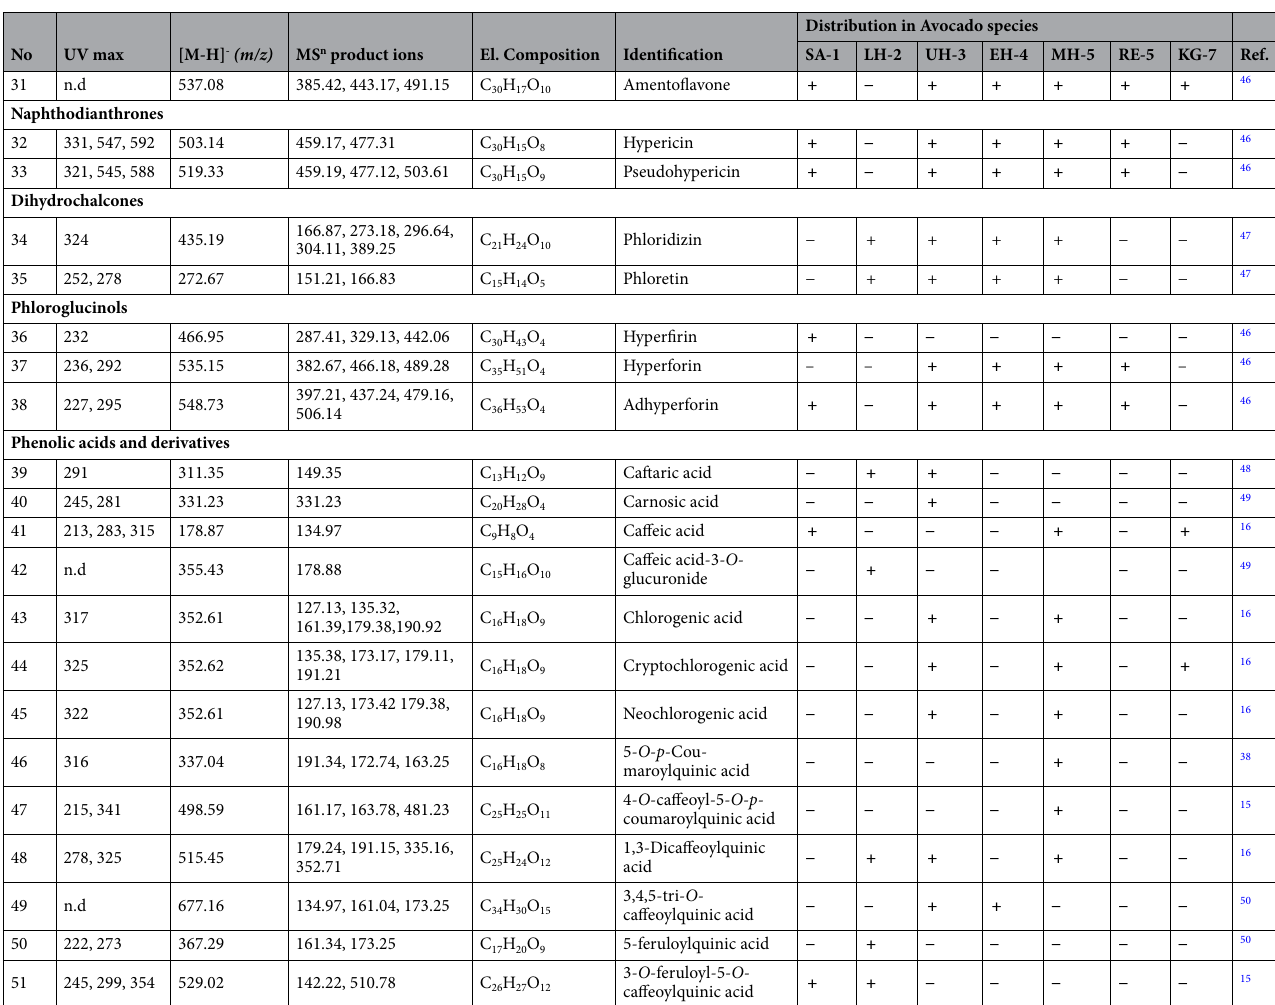
Table 1. Tentative identification of secondary metabolites in the studied avocado seed extracts using HPLC– PDA/MS/MS. (+) and (−) indicate the presence and absence of the metabolites, n.d; not